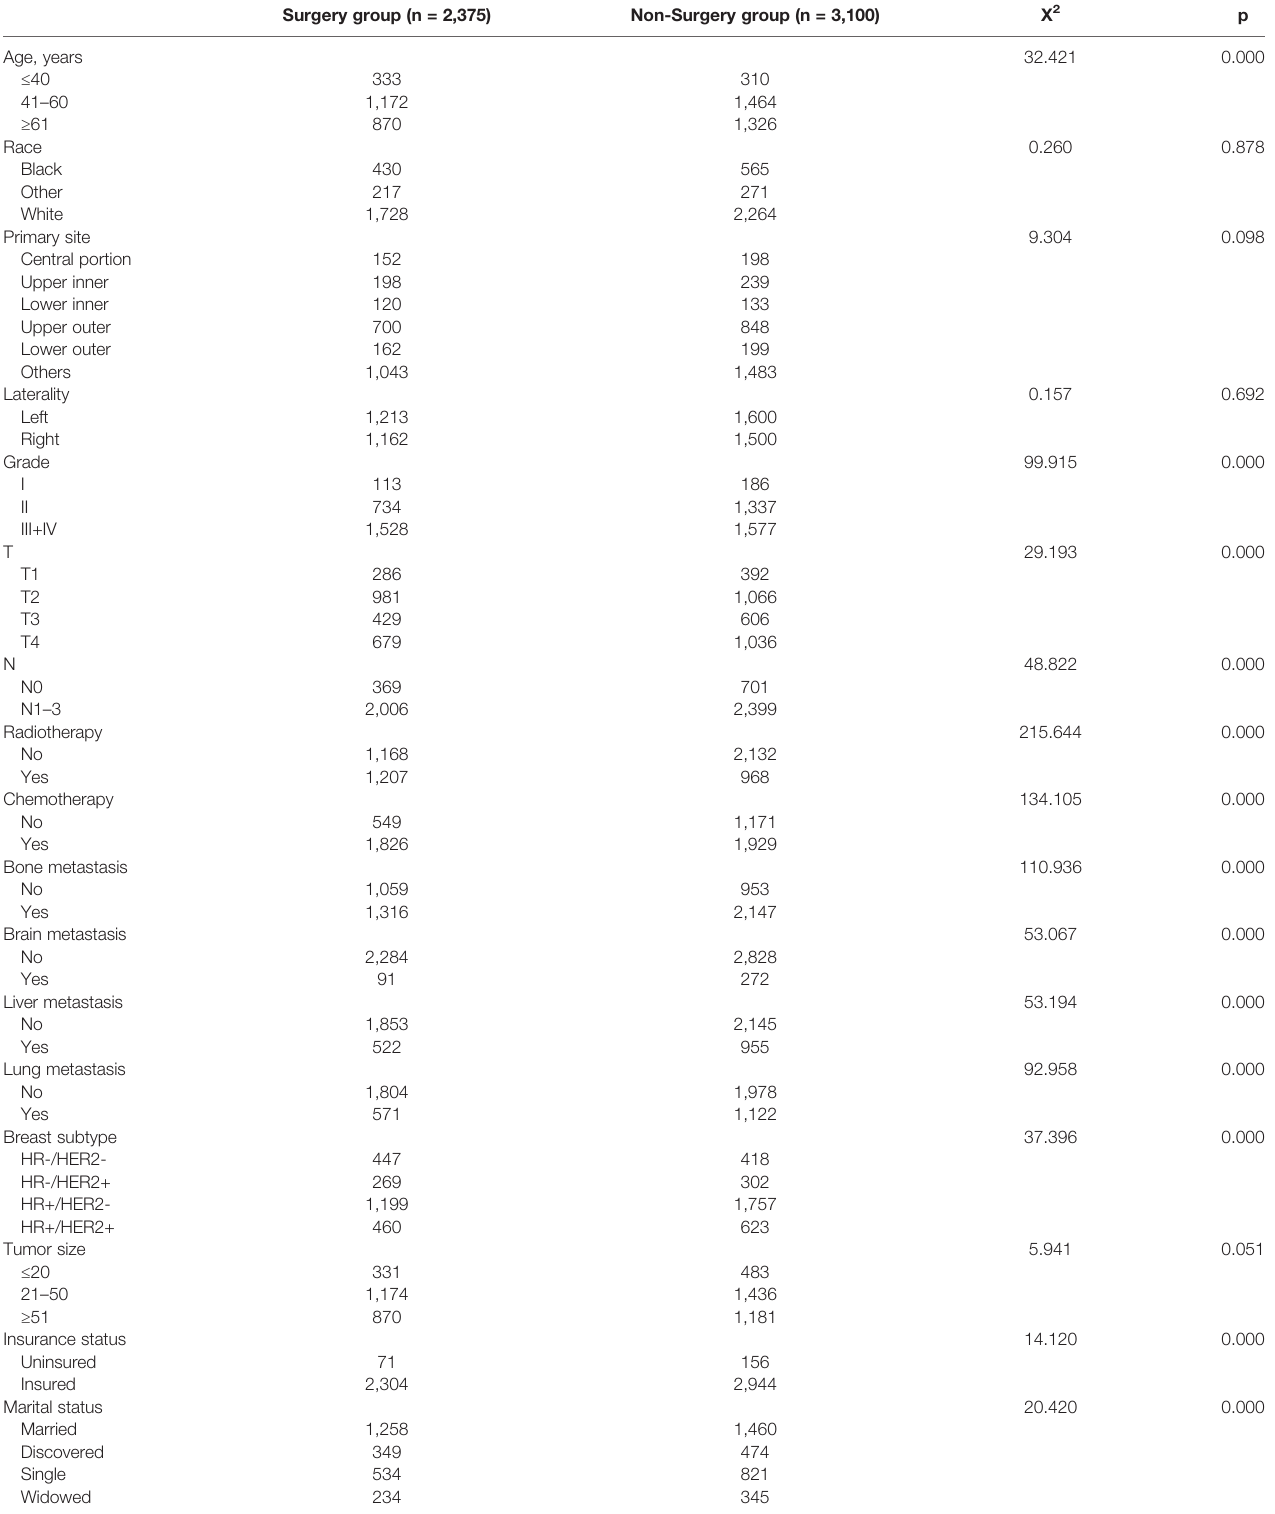
TABLE 1 | Clinical and pathological characteristics for female patients with stage IV IDC of breast before